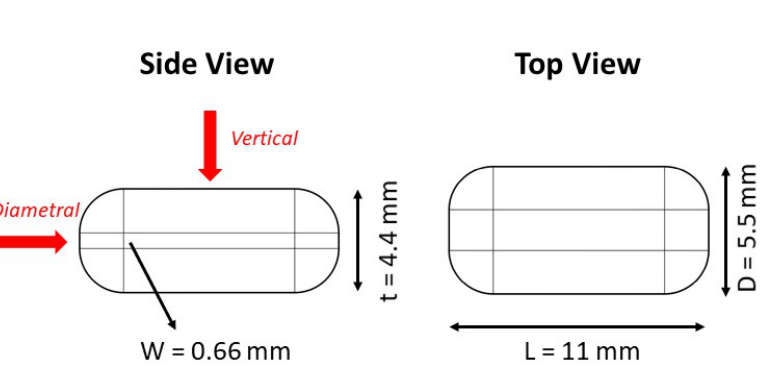
Figure 1. A graphical representation with dimensions of the fixed-size caplet used in this study. The two directions for the mechanical tests are displayed with red arrows. Table 1. Overview of factor settings in the experimental